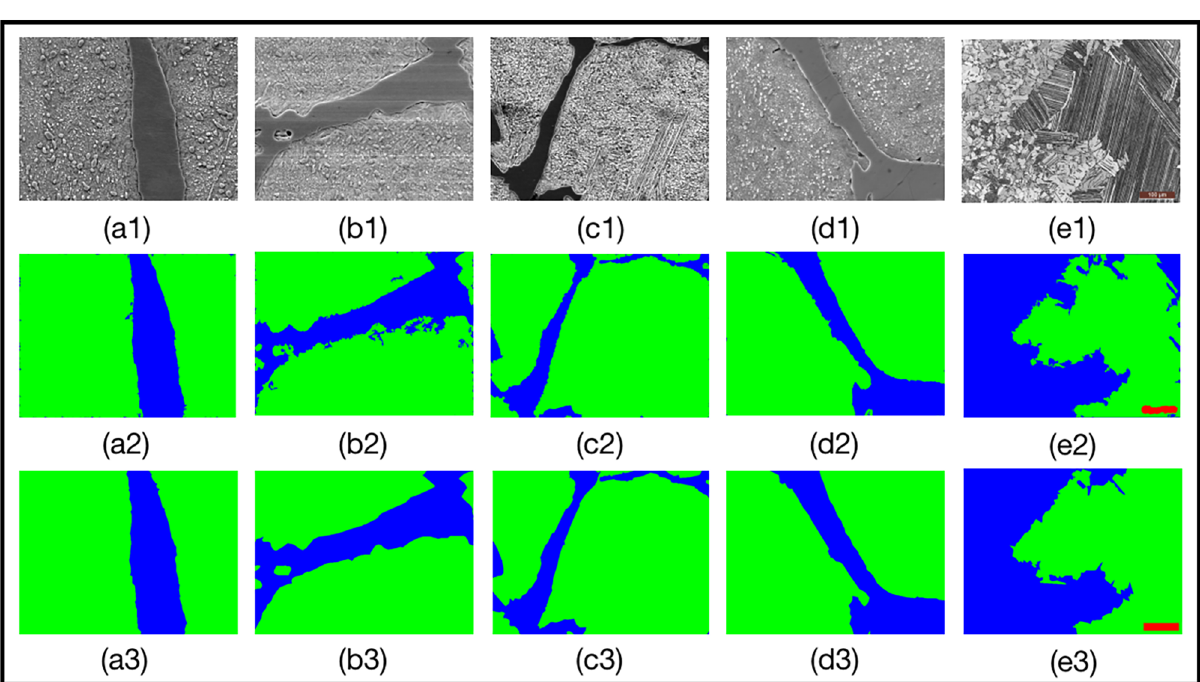
Figure 6. Results with our CES models after post-processing. ( a1 , b1 , c1 , d1 ) are the original carbon steel images; e1 is the original TiAl image; ( a2 , b2 , c2 , d2 , e2 ) are the results with our method, respectively; ( a3 , b3 , c3 , d3 , e3 ) are the ground truth of the images. The primary microconstituent of a1, b1 and d1 is spheroidite, and the primary microconstituent of c1 is pearlite and spheroidite. The primary microconstituent of e1 is equiaxed structure and lamellar structure.